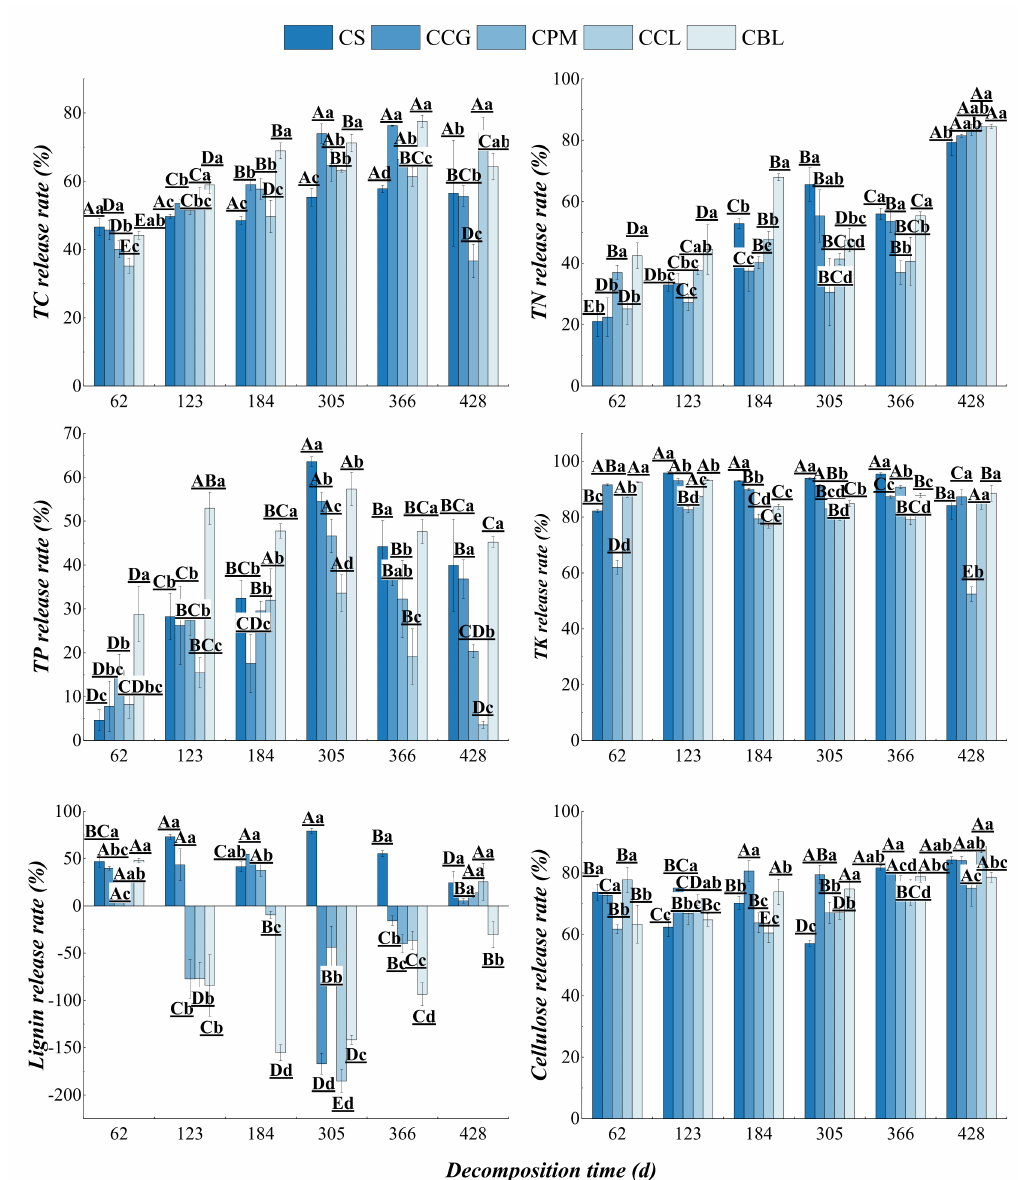
Figure 5. Dynamic changes in the nutrient release of different plant residues during the decomposition process. Note: A, B, C—differences between decomposition stages of the same treatment ( p < 0.05); a, b, c—differences between treatments in the same decomposition period ( p <